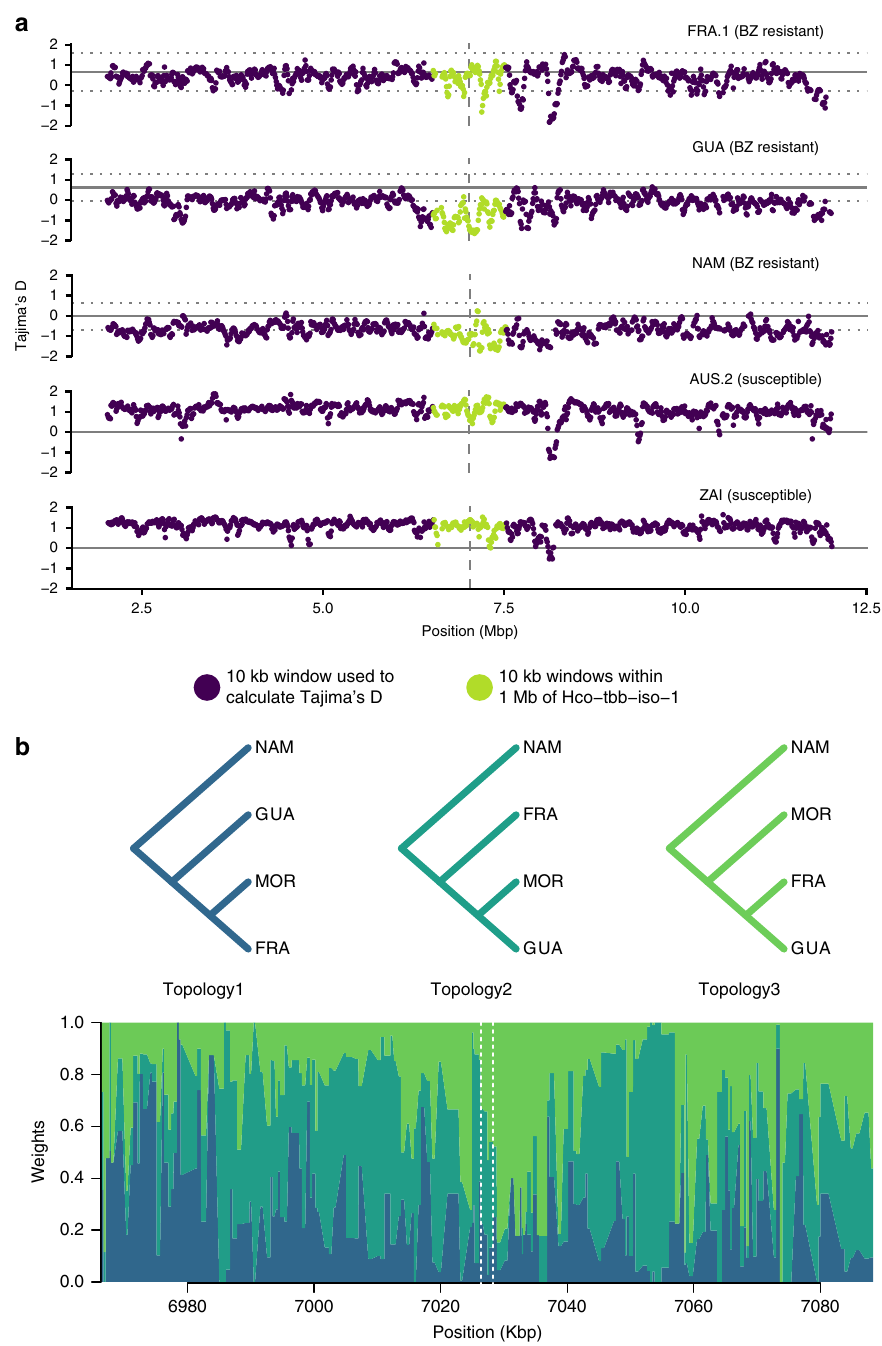
Fig. 4 Exposure to benzimidazoles leaves a major genomic footprint. a Tajima ’ s D surrounding the Hco-tbb-iso-1 locus on chromosome I. A total of 10-Mbp surrounding was considered (purple), of which 1 Mbp nearest to Hco-tbb-iso-1 is highlighted (green). Isolates compared included benzimidazole-resistant French (FRA.1), Guadeloupian (GUA), Namibian (NAM) or benzimidazole susceptible Australian (AUS.2), and Zaire (ZAI) isolates. Mean expected Tajima ’ s D (solid grey line) and 99% con fi dence interval (dotted line) were estimated from a 1000 simulated 10-Kbp wide sequences following MSMC- inferred demography. b Topology weighing analysis of a 100-Kbp window centred on Hco-tbb-iso-1 . At each position, the weight of each of the three possible topologies inferred from 50 Kbp windows is overlaid. Topology 2 (dark green) corresponds to an isolation-by-distance history, whereas topology 3 (light green) would agree with shared genetic material between worm isolates from French mainland into Guadeloupe. The Hco-tbb-iso-1 locus is indicated by vertical dashed GO term enrichment analysis of all XP-CLR signi fi cant regions identi fi ed 26 signi fi cant terms (Supplementary Table 4). The top 10 most-signi fi cant GO terms encompassed enzymatic- related activity, neurotransmitter transporter activity